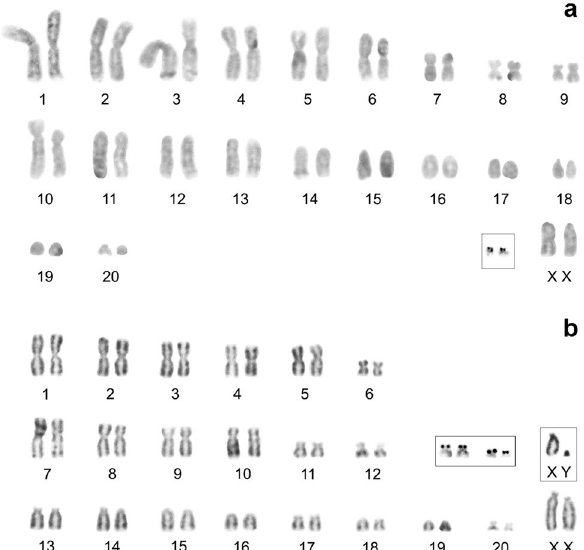
Figure 4. Conventionally stained karyotypes. ( a ) Sorex thibetanus from Gansu Province (Lianhuashan), 2n = 42, NF a = 60; ( b ) Sorex cansulus from Sichuan Province (Songpan County), 2n = 42, NF a = 64. XX: female sex chromosomes. Male sex chromosomes XY are boxed. Pairs bearing NORs in both karyotypes are